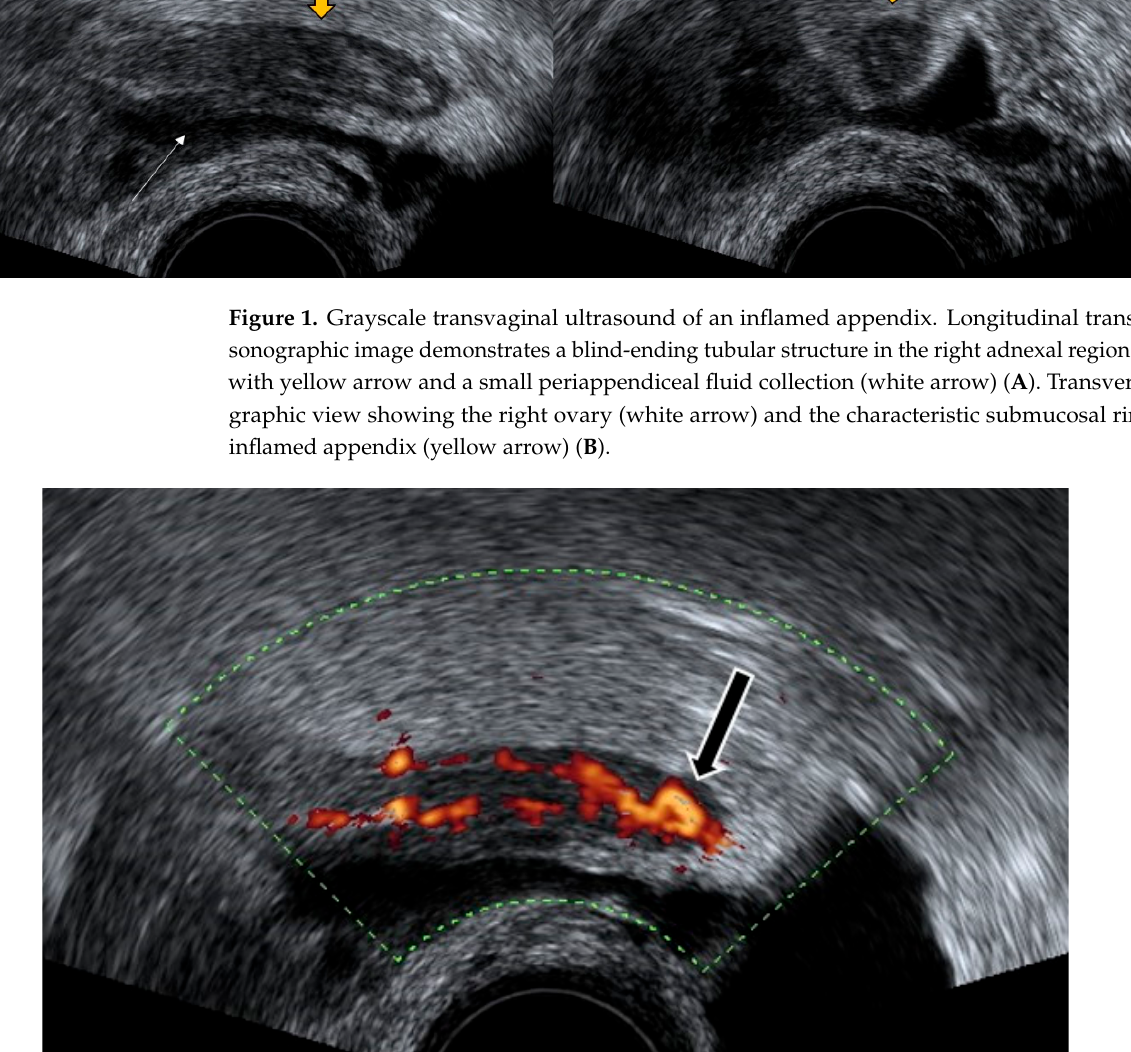
Figure 2. Power Doppler demonstrates hyperemia in the wall of the appendix (black arrow).